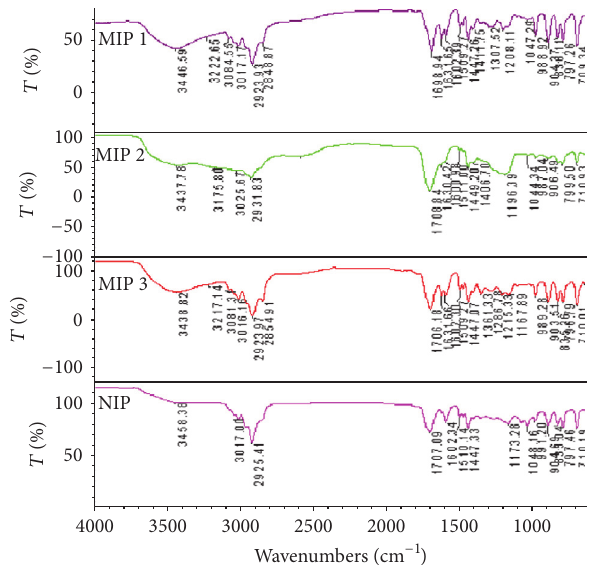
Figure 3: FTIR spectra of MIPs with template in comparison with